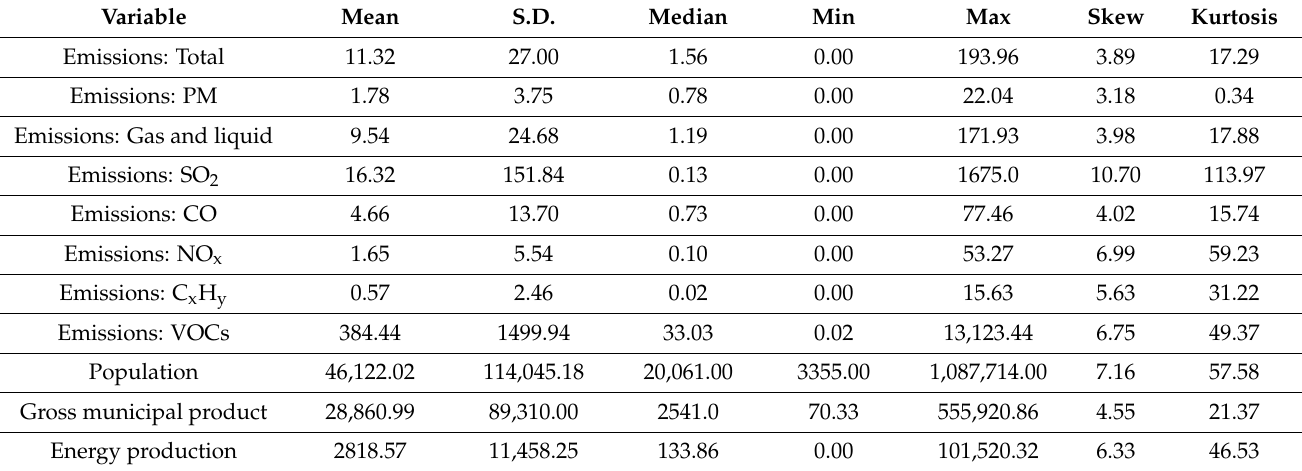
Table 3. Summary statistics of the